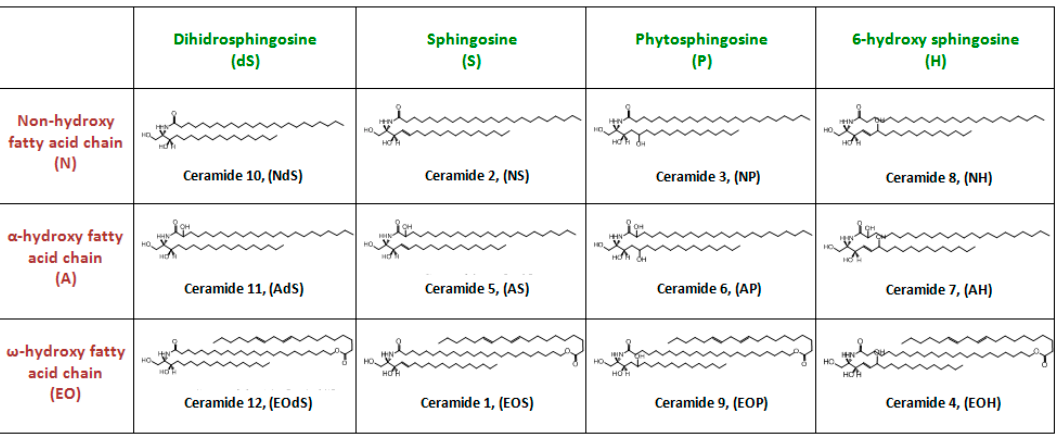
Figure 4. The identified ceramide types in the human stratum corneum.